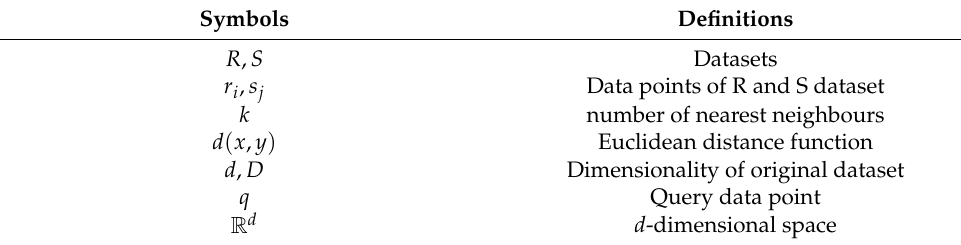
Table 2. Summary of commonly used symbol and